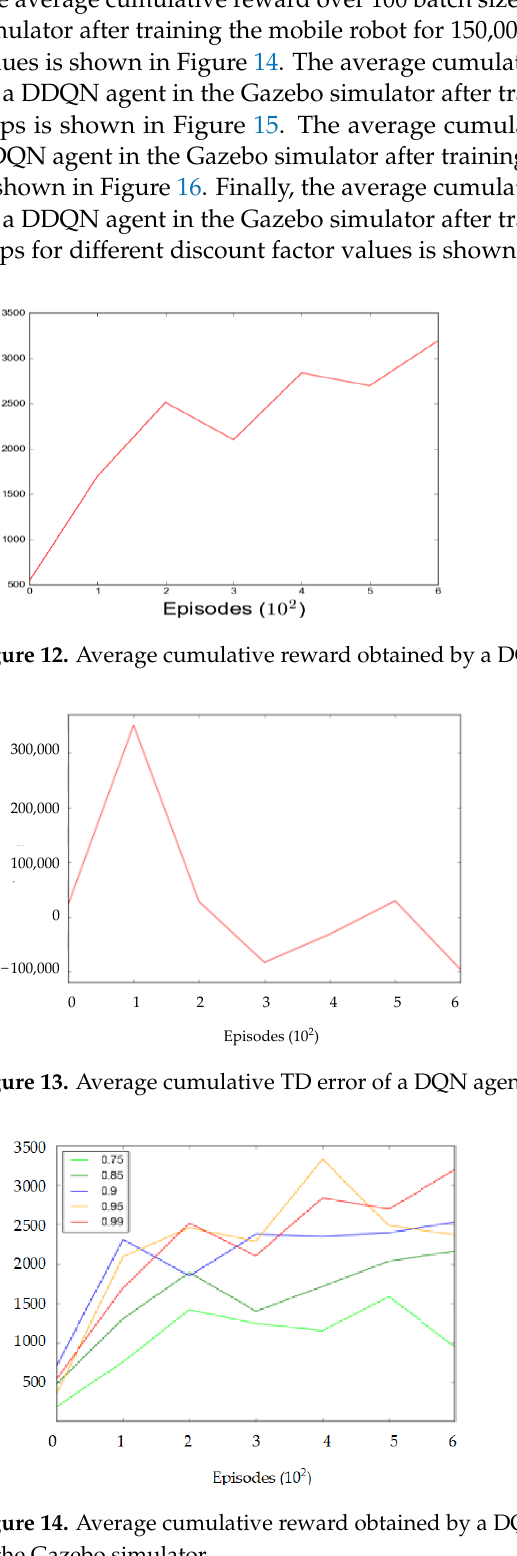
Figure 11. The depth image of the target object from an RGB−D camera.